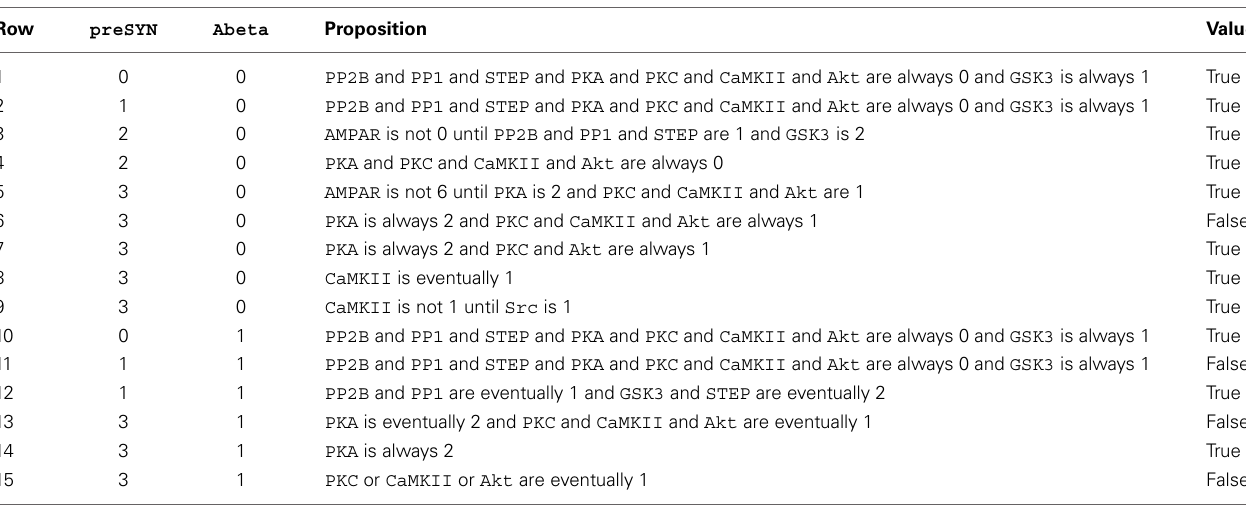
Table 3 | Results of temporal-logic model checking in the absence or presence of Abeta . Row